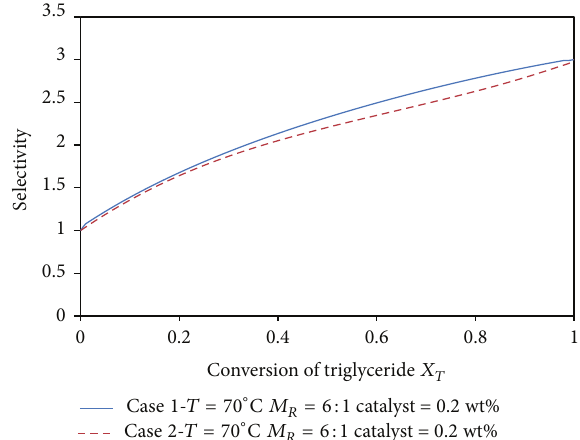
Figure 2: Selectivity plots of Cases 1 and 2 at reaction temperature 70 ∘ C, molar ratio 6: 1, and catalyst concentration 0.2 wt.%.